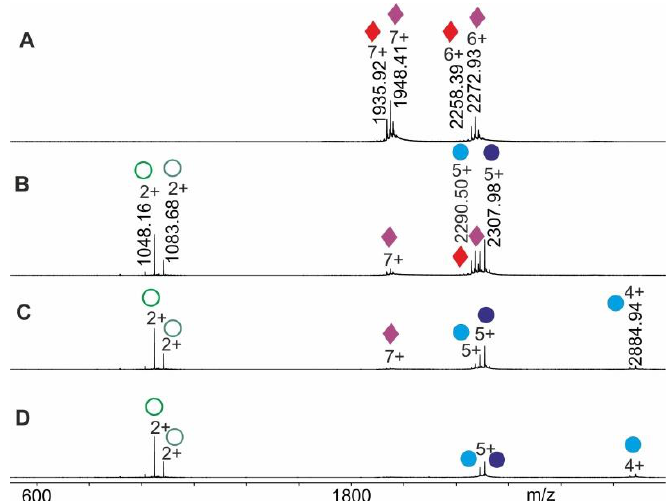
Figure 5. Nano-ESI mass spectra from RNAse S dissociation experiments. Di ff erent collision cell voltage di ff erences ( ∆ CV ) are shown. ( A ) 3 V. ( B ) 17 V. ( C ) 30 V. ( D ) 50 V. Charge states and m / z values for selected ion signals are given for RNAse S ions (red / purple diamonds on right ion series), S-protein ions (light blue / dark blue filled circles on right ion series) and for the released S-peptide ions (light green / dark green circles on left ion series). Solvent: 200 mM ammonium acetate, pH